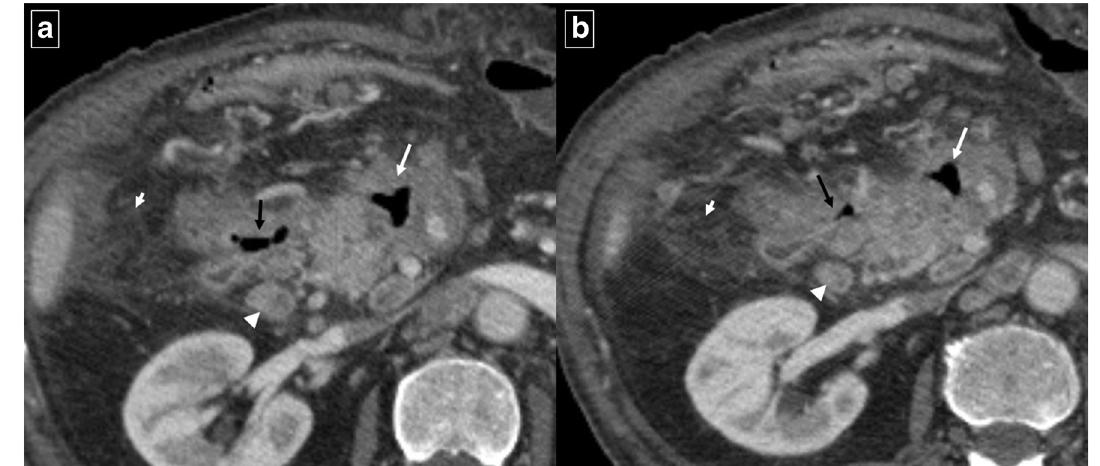
Fig. 9 Tuberculosis in a 63-year-old man with constitutional symptoms, fever, and abdominal pain. Axial contrast-enhanced CTshows a masslike appearance (white arrow) that encompasses the superior mesentericartery and a fistulous pathway that communicates with the duodenal lumen